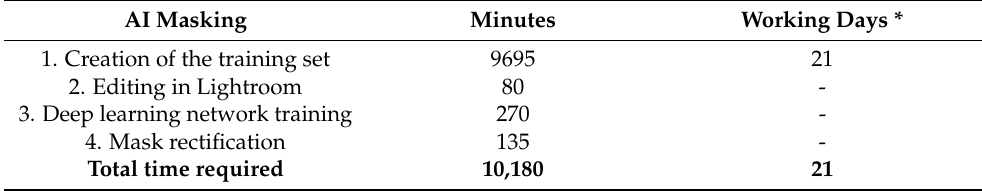
Table 3. Time required for automated image masking activities (in bold the total time).